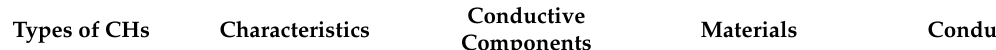
Table 1. Typical examples of different types of